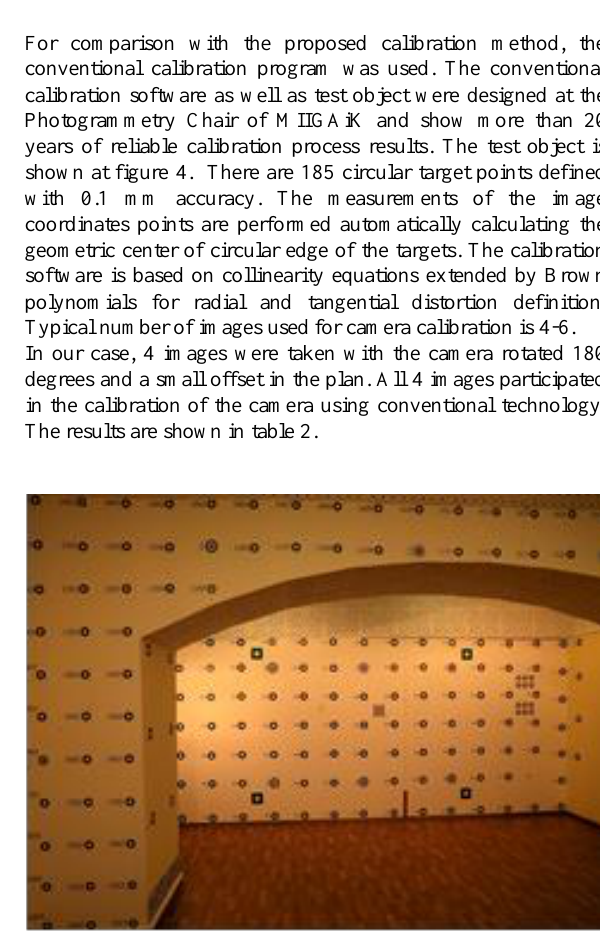
Figure 4. The calibration test object.